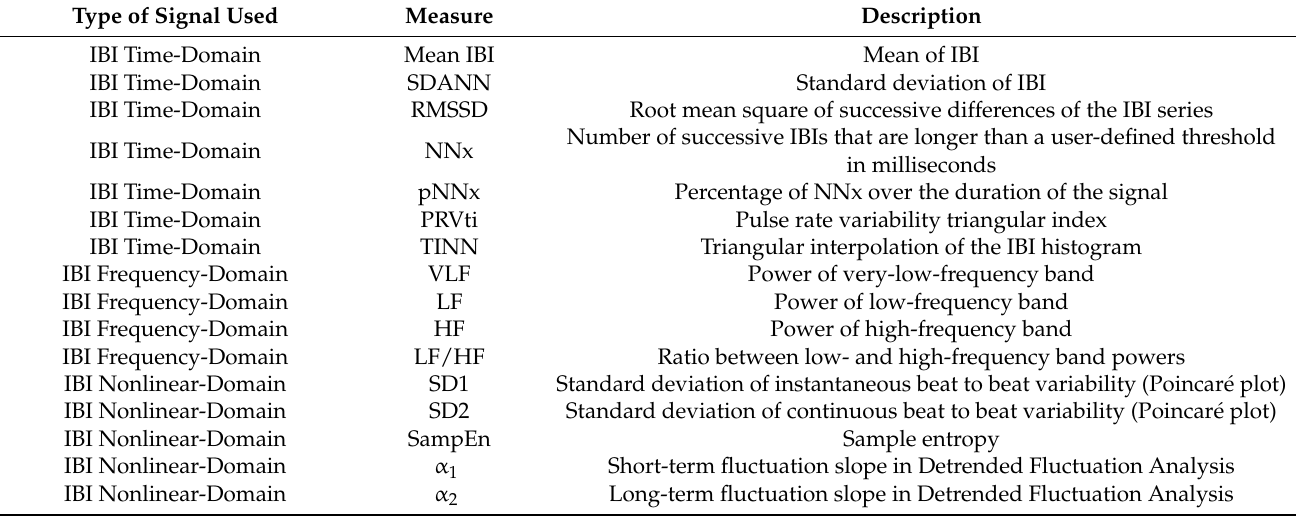
Table 1. List of considered features related to the cardiovascular dynamics used in this